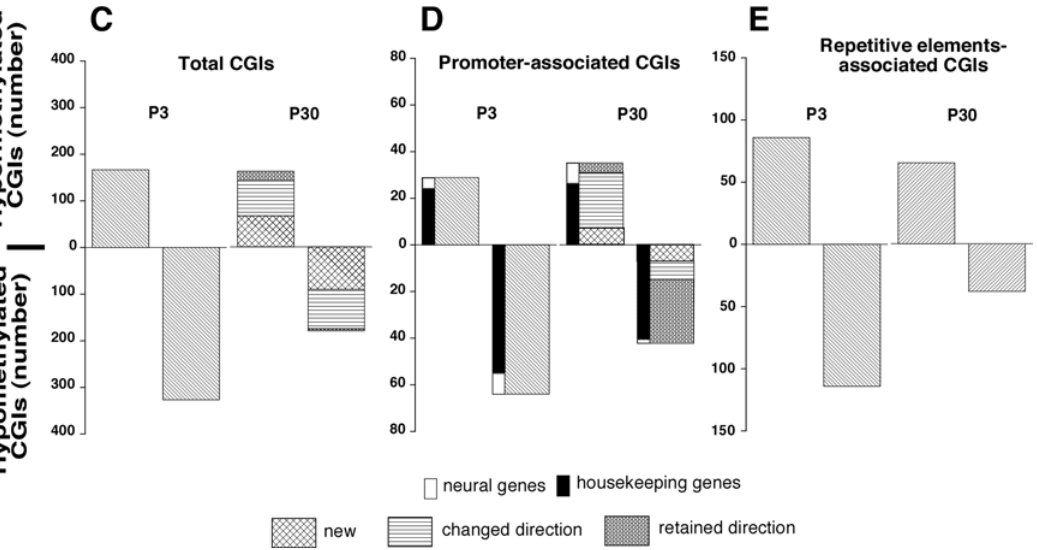
Figure 8. Effects of maternal cocaine exposure on CGI DNA methylation in P30 compared to P3 pups. (a) Cocaine-induced hypermethylated and hypomethylated CGIs in P30 compared to P3 pups. Shown are the numbers of CGIs with altered methylation levels in cocaine- treated animals relative to saline-controls at each age. For P30 data, the number of CGIs with altered methylation levels that did not show a change at P3 ( new ) are indicated by a cross-hatched segment of the bar. Also indicated by differential shading are CGIs that were significantly altered at both P3 and P30, retaining or reversing their direction of change at P30 compared to P3 ( retained direction; changed direction ). (b) Hypermethylated and hypomethylated promoter-associated CGIs at P3 and P30. For both ages, CGIs associated with promoters of neural tissue-specific genes ( neural genes ) are represented by white bars, while CGIs associated with promoters of non-neural tissue-specific genes ( housekeeping genes ) are represented by black bars. In addition, for P30, the number of CGIs with altered methylation state undetectable at P3 ( new ) and the number of CGIs corresponding to the CGIs affected at P3, which either retained or reversed the direction of change ( changed direction/retained direction ), are indicated as in a . (c) Abnormally methylated repetitive element-associated CGIs at P3 and P30.